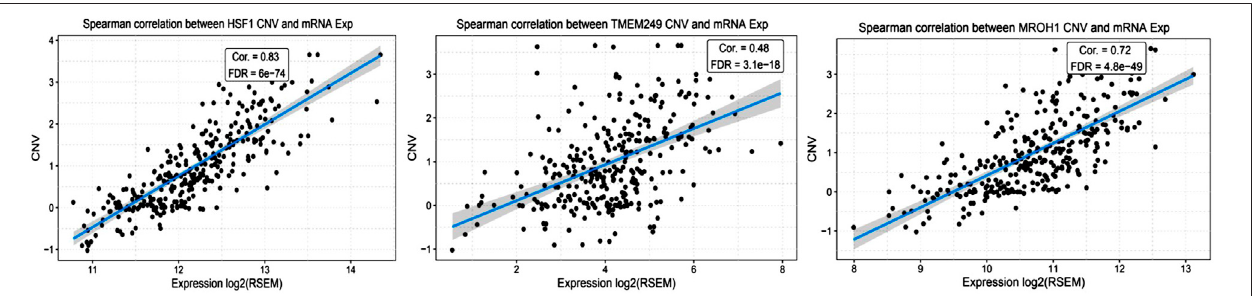
FIGURE 6 | Correlation study between mRNA levels and copy number variation of three genes related to NAC resistance through cBioPortal in TCGA-ovarian cancer patients. The correlation coef fi cient analysis shows the positive association between mRNA expression and copy number variation of HSF1, TMEM249, and MROH1 across 585 ovarian cancer patients from TCGA.